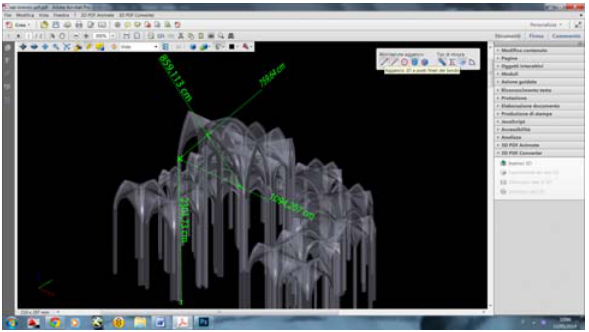
Figure 13 . Naples S. Lorenzo Maggiore. 3D PDF: testing 3D Measurement